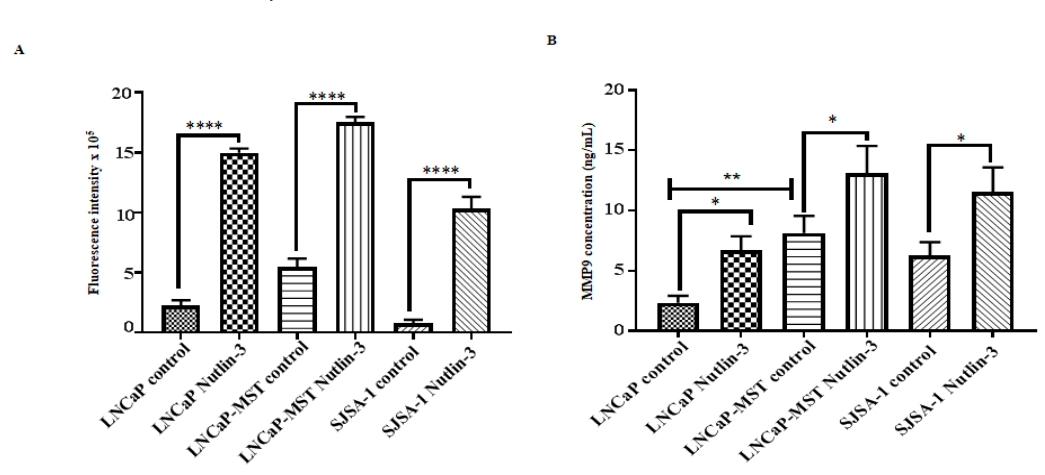
Figure 7. ( A ) The role of MDM2 expressing cells in MMP activity in LNCaP, LNCaP-MST, SJSA-1 and after Nutlin-3 (20 µM) treatment. Results showed that MMPs fluorescence intensity corresponded to the MMPs activity from cell culture supernatant (**** p < 0.0001). ( B ) MMP9 ELISA from cell culture supernatant displayed a significant increase in MMP9 secretion in MDM2 transfected LNCaP-MST compared to LNCaP and Nutlin-3, which increased the secretion of MMP9 in LNCaP, LNCaP-MST, and SJSA-1 (* p < 0.05) (** p < 0.01).